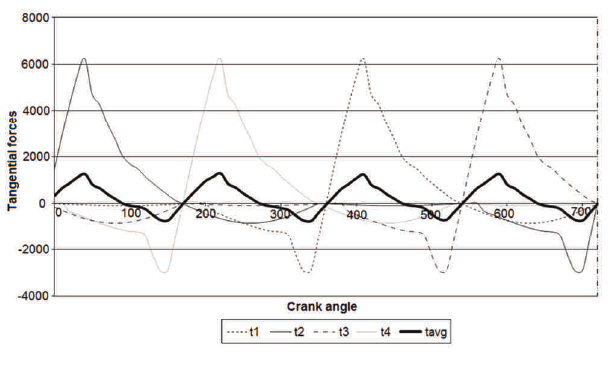
Fig. 3. The tangential force – no burning in four